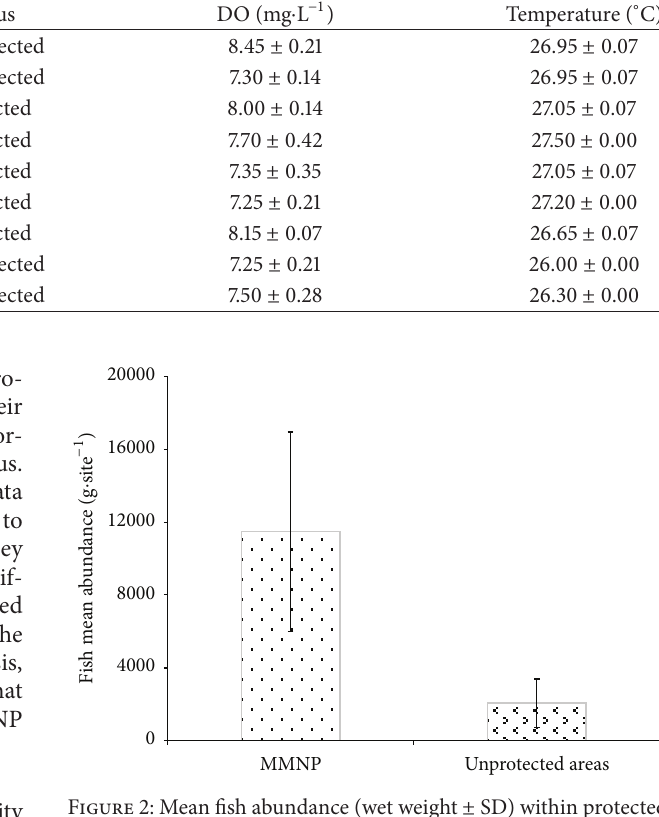
in the unprotected areas (Table 2). The species belonged to nine families (number of species in parentheses): Cichlidae (41), Mastacembelidae (3), Mochokidae (3), Claroteidae (3), Latidae (2), Mormyridae (2), Clupeidae (1) , Cyprinidae (1) , and Poeciliidae (1) . Haplotaxodon microlepis and